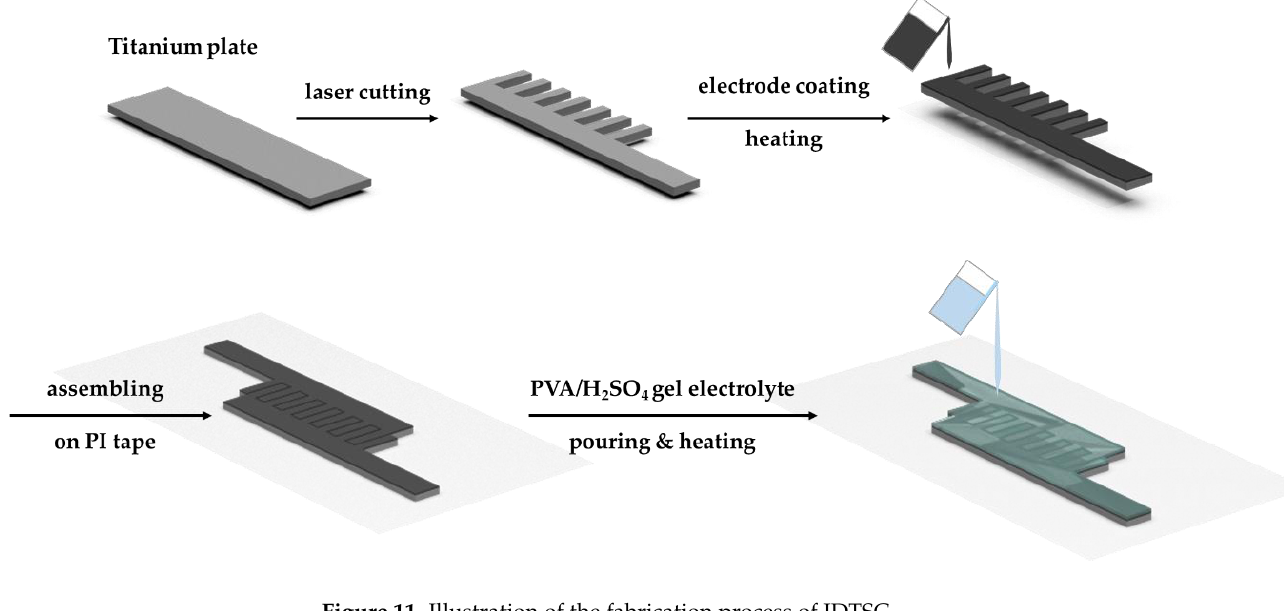
Figure 11. Illustration of the fabrication process of IDTSC.